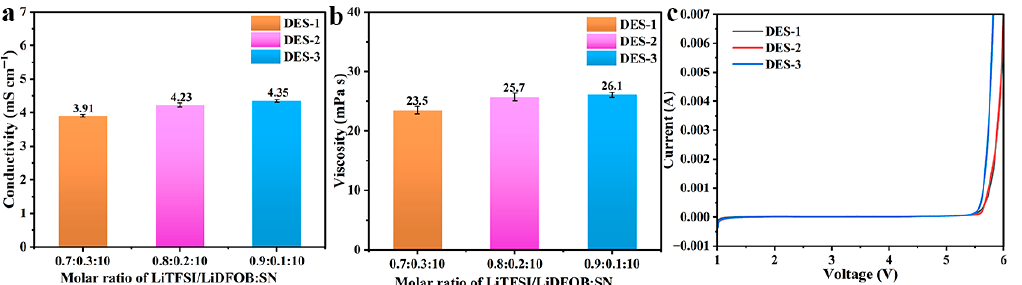
Figure 2. ( a ) The conductivity and ( b ) viscosity of three DES electrolytes at 25 °C. ( c ) LSV plots of three DES electrolytes.